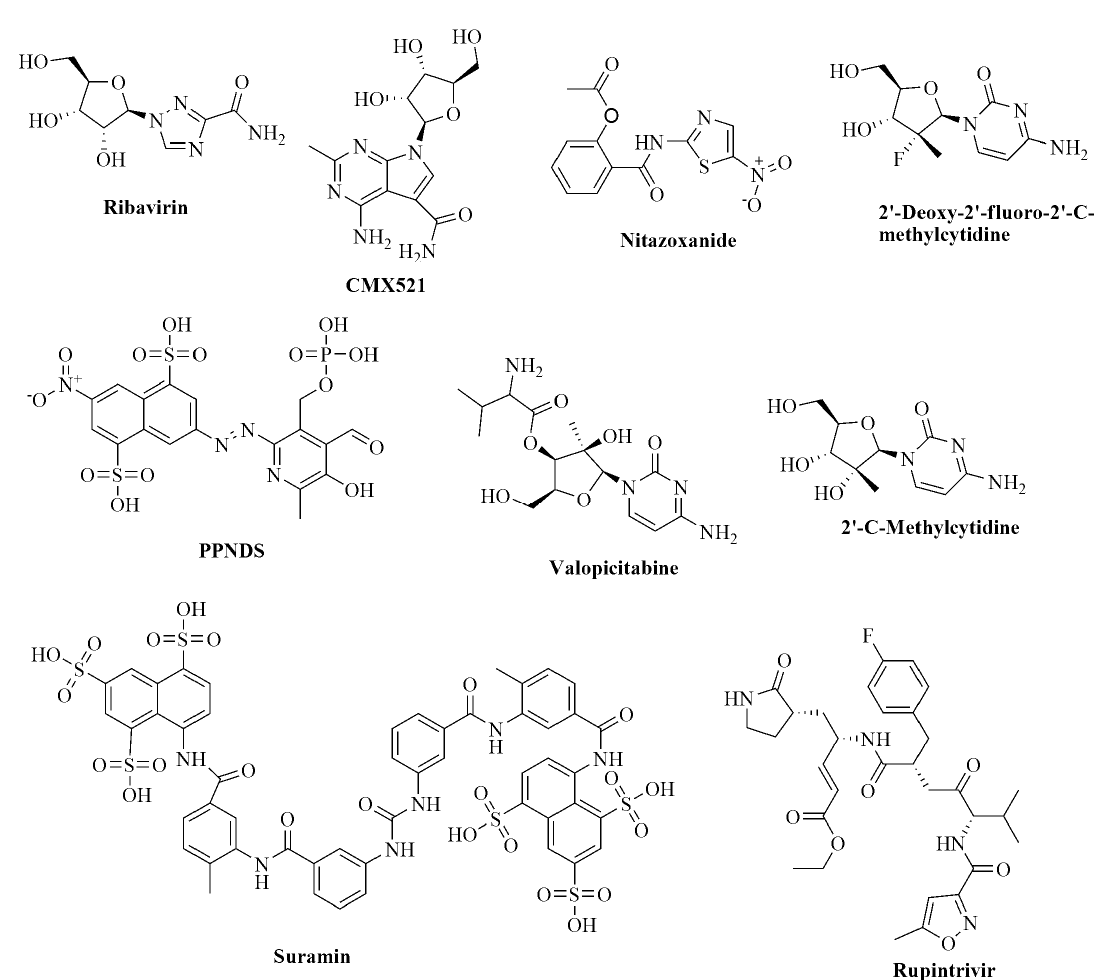
Figure 1. Chemical structure of known nucleoside and non-nucleoside inhibitors of norovirus.